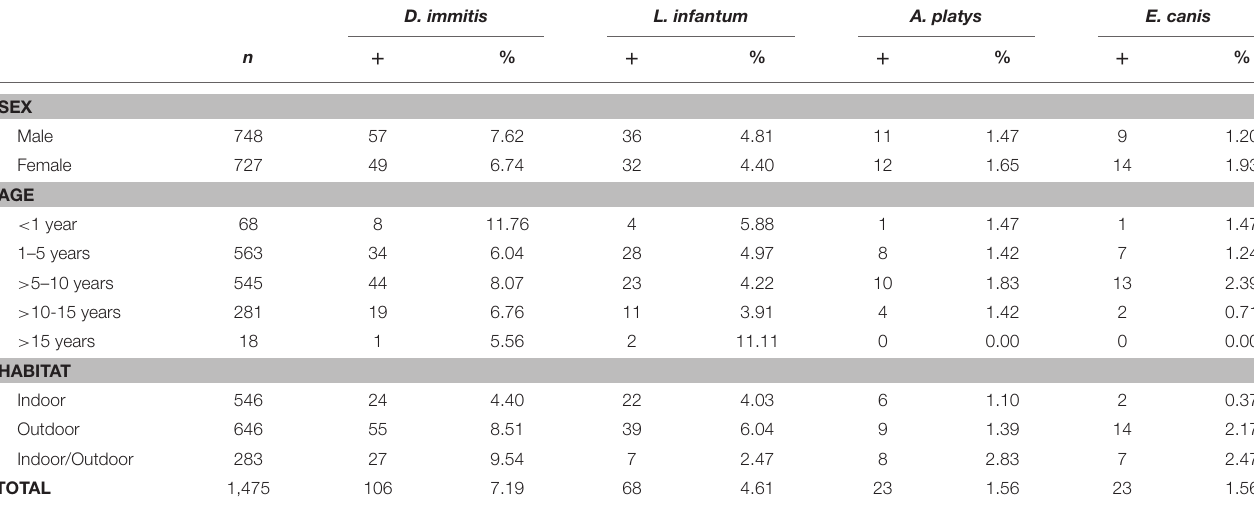
TABLE 1 | Prevalence and seroprevalences of the studied vector-borne infections by sex, age, and habitat in Castilla y León,